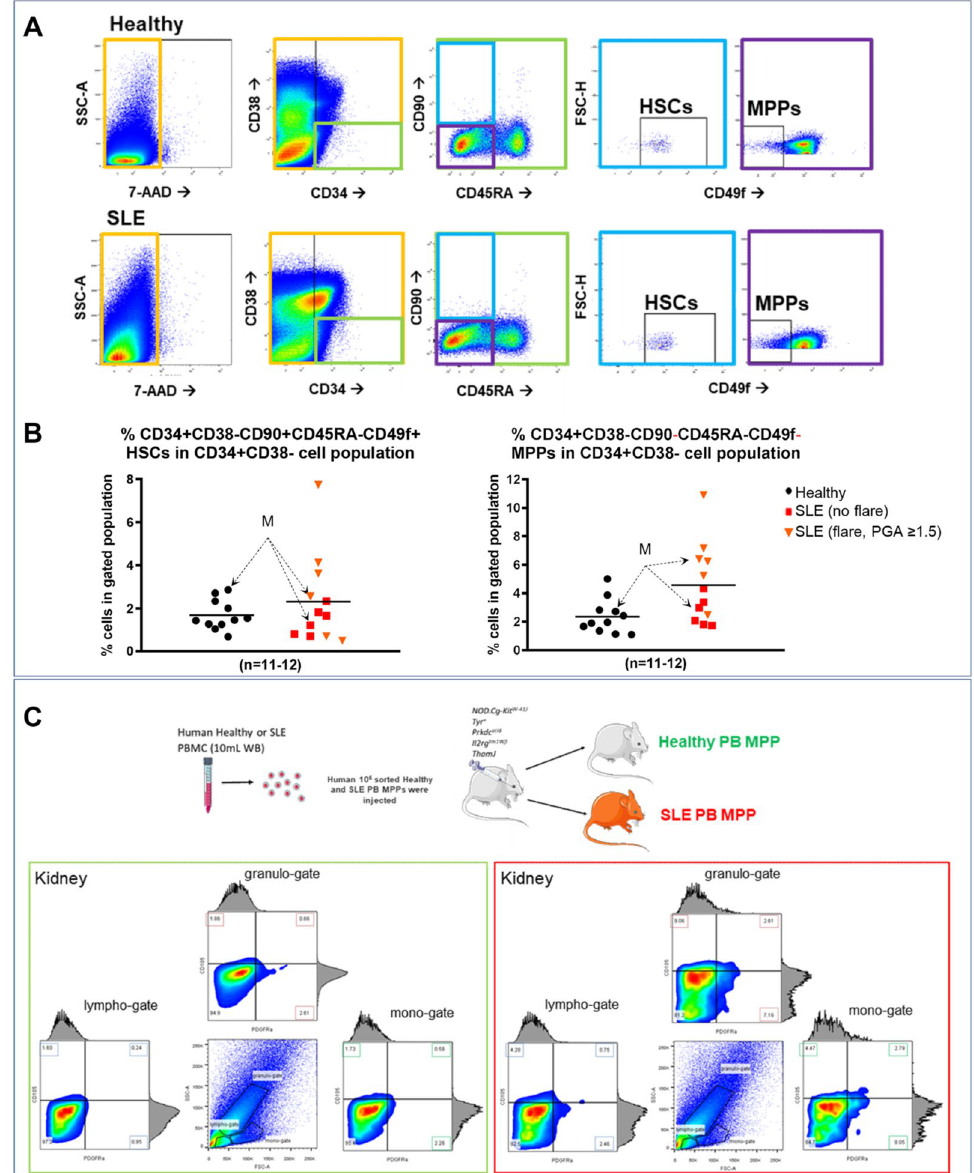
Figure 6. Peripheral blood MPP number is elevated in SLE and migrate preferentially to the kidneys. ( A ) Gating strategy for obtaining human HSC and MPP cell populations from PBMC from healthy (n = 11) and SLE (n = 12) individuals. These representative graphs from a total of gated live cell population (7AAD, orange gate) was initially gated for CD34 + CD38- progenitor pool (green gate), which was further examined for CD45RA − CD90 + CD49f + HSCs (light blue gate) and CD45RA − CD90 − CD49f − MPPs (purple gate). ( B ) X–Y graphs showing the percentage of HSCs and MPPs in PBMC-gated and CD34 + CD38 − -gated cell populations (and mean values). There are statistically more MPPs in the CD34 + CD38 − -gated cell populations that is linked to SLE flare and PGA > 1.5, at the time of sample collection (orange triangles, p < 0.03, Student’s T-test). No statistical difference in HSC percentage between SLE and Healthy PB ( p = 0.35, Student’s T-test). M = male subjects. ( C ) Mice were sacrificed at 5 weeks and kidney-derived cells were subjected into immunostaining with antibodies against human-only surface markers for CD105 and PDGFRα, in order to assess human cell presence. Lympho-gates, granulo-gates and mono-gates represent different immune cell subpopulations and therefore examined separately, according to their FSC/SSC readout N =